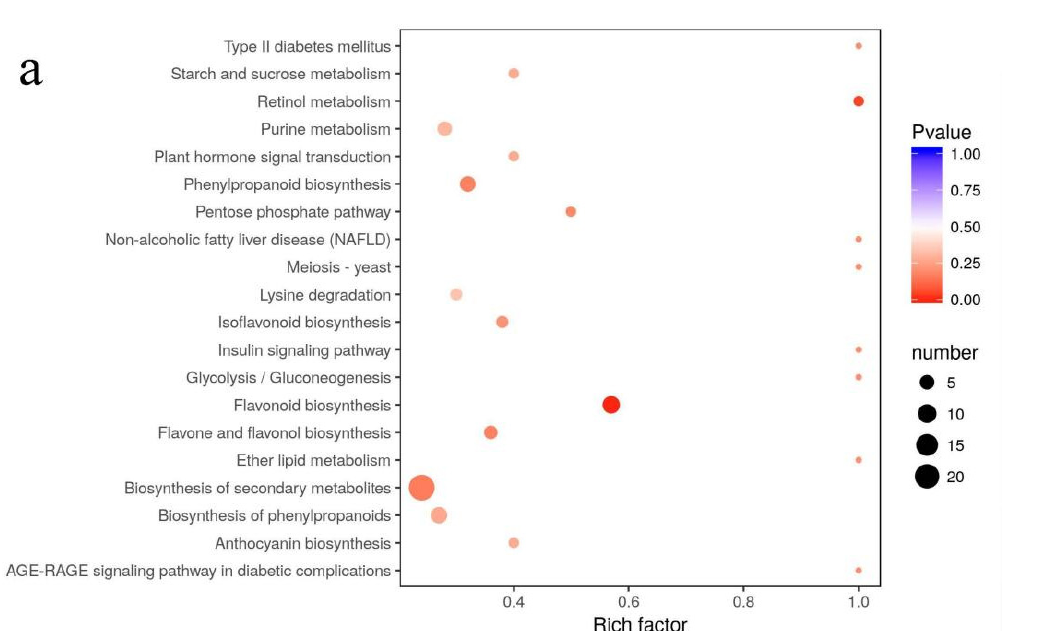
Figure 2. Metabolome of mature pericarp of B214 and B227: ( a ) KEGG enrichment of DAMs in mature pericarp of B214 and B227. X -axis represents rich factor of each pathway and y -axis repre- sents the names of pathways. Color of bubbles indicates the p -value, the redder, the more signifi- cant. Size of bubbles indicates the number of metabolites included in the pathway. ( b ) Representa- tives of 10 most up-accumulated and 10 most down-accumulated metabolites in B214. X -axis rep- resents the value of Log2FoldChange (B214/B227) and y -axis represents the index of metabolites (Table S1).